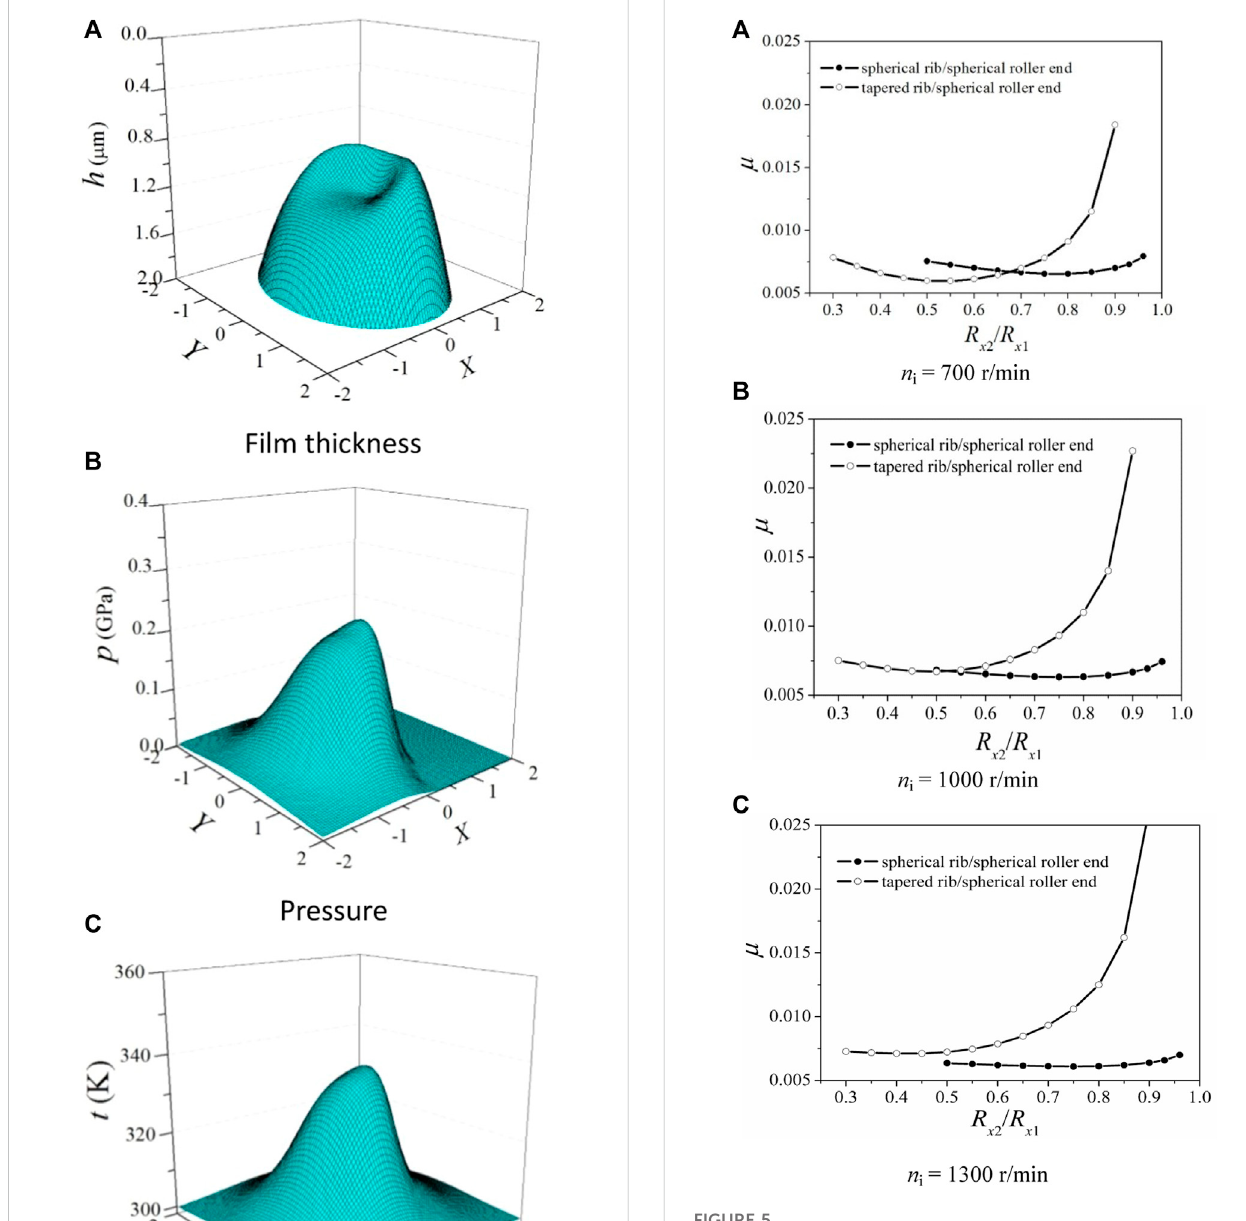
FIGURE 5 Variations in the frictional coef fi cient versus R x 2 / R x 1 with various rotation speeds for w = 560 N. (A) n i = 700 r/min, (B) n i = 1,000 r/min, and (C) n i = 1,300